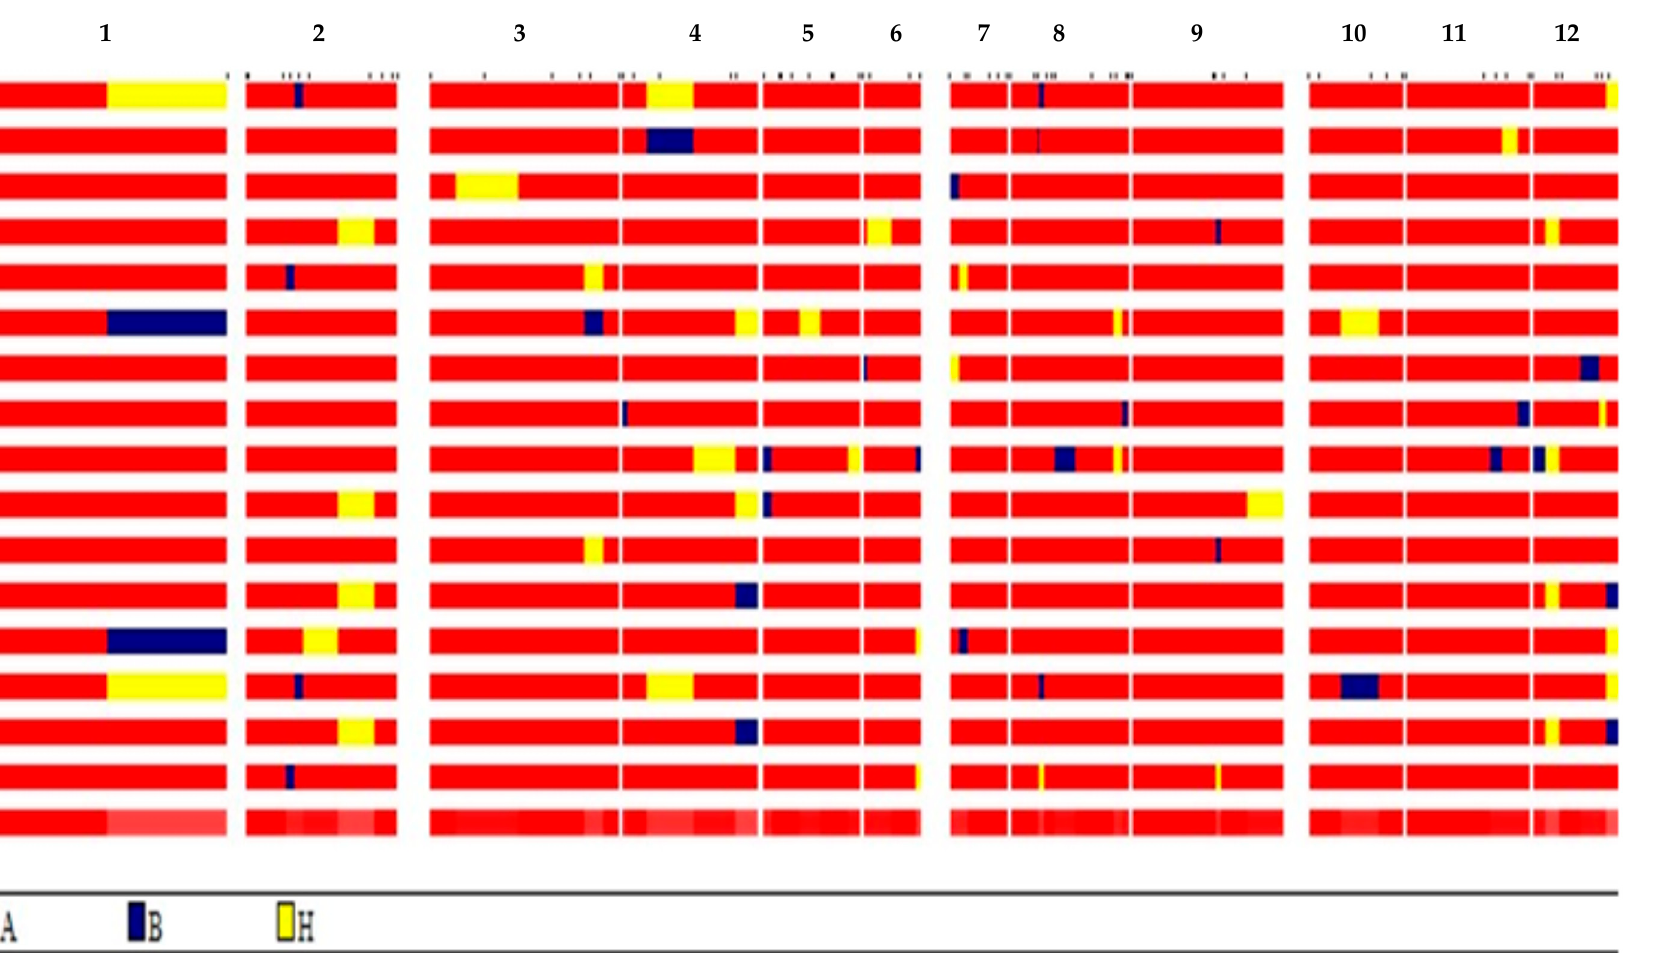
Figure 1. All linkage groups across 12 chromosomes of the 16 improved selected rice lines. Note: Red lines represent homozygous regions for recurrent parent (Putra-1) alleles, blue lines represent homozygous regions for donor parent (IRBB60) alleles while yellow lines represent heterozygous regions.